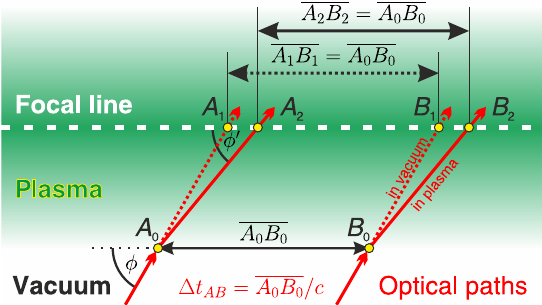
FIG. 6. Laser beam refracted at the vacuum-plasma boundary. Because of the same optical path of A 0 A 2 and B 0 B 2 seen by the TWEAC laser at different positions of incidence along the y axis, the difference in arrival times at A 2 B 2 is the same as A 0 B 0 . Thus, the relation between pulse-front tilt and incident angle ϕ does not change in the plasma of a slit-nozzle gas jet, as long as it is translationally symmetric along the line